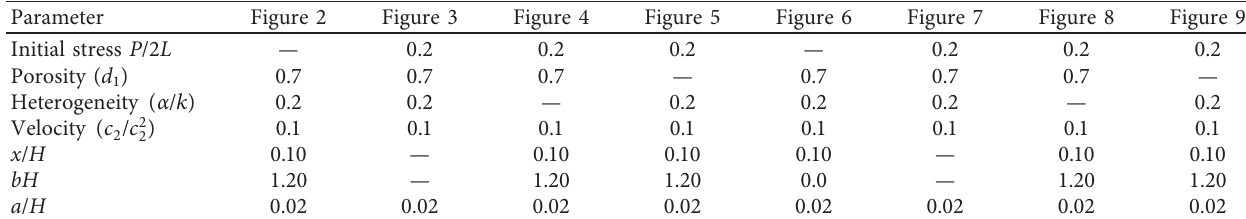
Table 1: General data of parameters for graphical results in mountain surface.